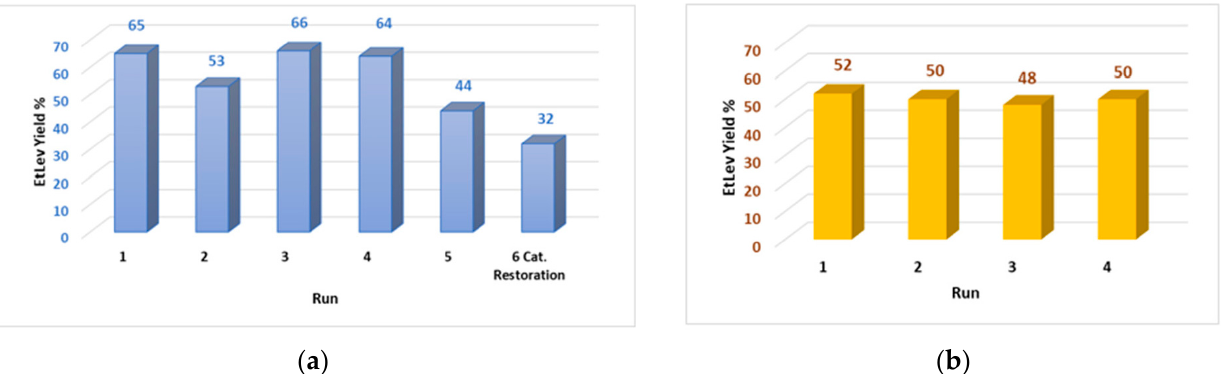
Figure 4. ( a ) Recycling of the catalyst Purolite CT151; FA (1.0 g, 10.19 mmol), EtOH (20 mL), Purolite CT1515 (100% wt.) at 80 °C for 5 h. ( b ) Recycling of the catalyst Purolite CT151 and of the exceeding ethanol; FA (5.0 g, 50.9 mmol), EtOH (100 mL), Purolite CT1515 (100% wt.) at 80 °C for 5 h.